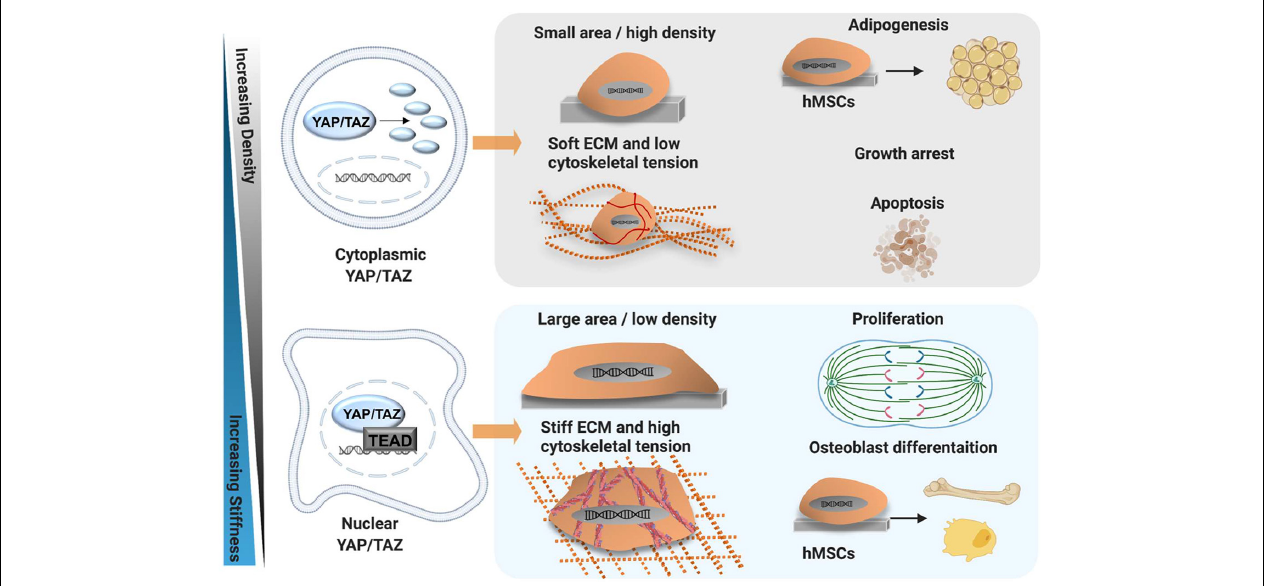
FIGURE 5 | YAP/TAZ mechanism of action. Schematic showing mechanical regulation of YAP/TAZ activity and modulation of cell behaviour by YAP/TAZ in MSC. Osteogenesis and skeletal muscle fates are promoted by stiff ECM and a low cell density, allowing MSC to spread and generate cytoskeletal tension via F-actin stress fibres. The stiff matrix promotes stress fibre formation and YAP/TAZ nuclear translocation. Conversely, adipogenic fates are promoted by soft ECM and high cell-cell contact. The soft matrix prevents stress fibre formation, thus MSC cannot generate tension and display only cortical actin. As such, YAP/TAZ are retained in the cytoplasm, undergo proteasomal degradation and are rendered inactive, promoting adipogenesis. Created using